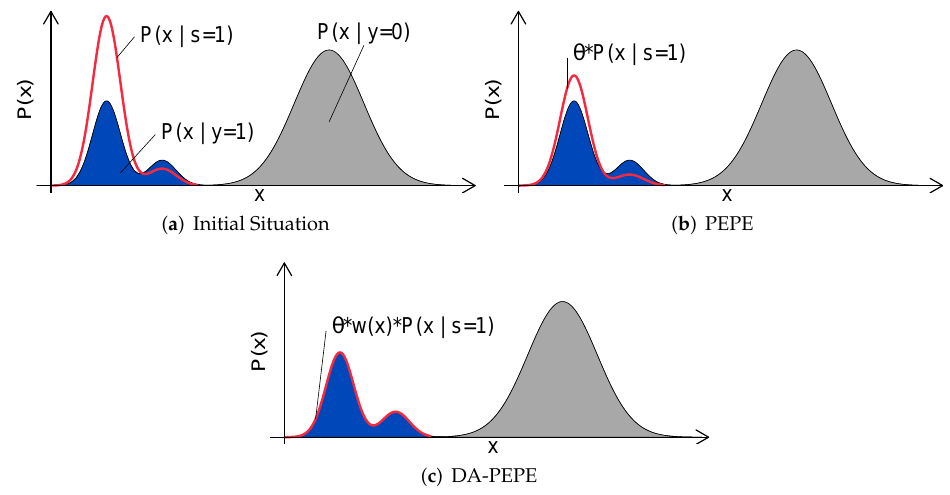
Figure 4. Schematic depiction PEPE and DA-PEPE (cf Section 2.2). ( a ) Initial situation: Colored area represents the density of the unlabeled data, with blue representing the positive data and gray representing the negative. The density of the sampled data is represented by the bold red line. ( b ) PEPE: θ is chosen to minimize the distribution of annotated and unlabeled data. ( c ) DA-PEPE: Applying domain adaptation allows a more accurate estimation of θ in the case of sampling